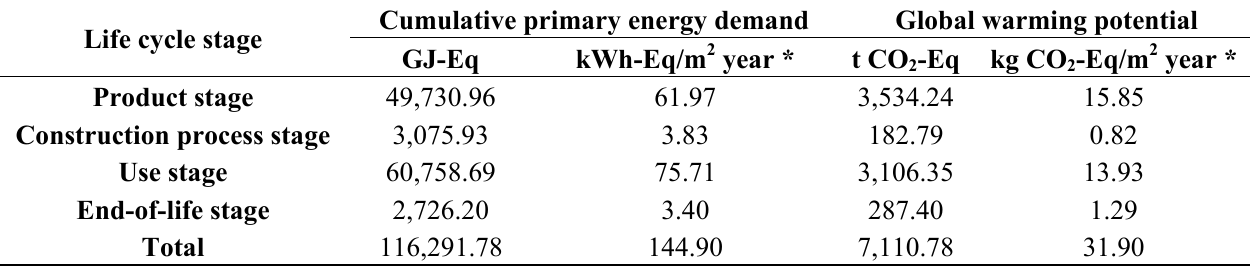
Table 7. Ratios of cumulative primary energy demand and equivalent emissions of CO the different life stages of the building analyzed (* the ratios are expressed in useful, air conditioned m 2